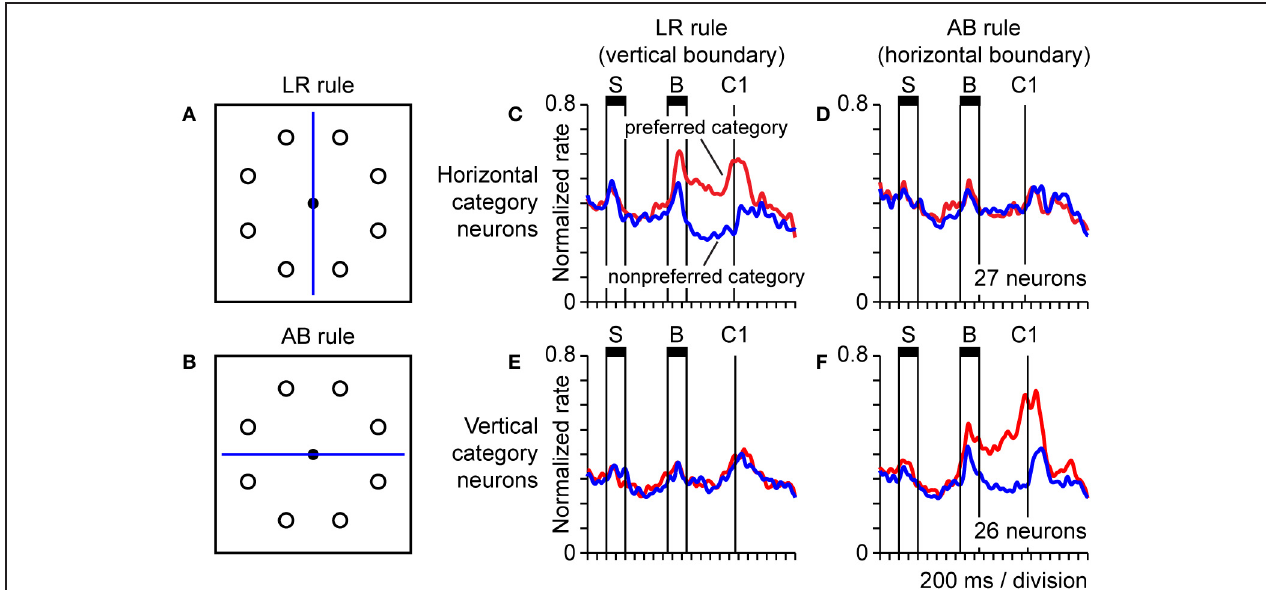
FIGURE 8 | Neural population activity encoding categorical spatial relationships in posterior parietal cortex area 7a. Monkeys performed a task in which they assigned a spot sample stimulus to one of two spatial categories on the basis of the spatial relationship between the sample and a line serving as a category boundary. We presented the sample and category boundary stimuli at different times in the trial, separated by an intervening delay. The durations of the sample and boundary cue are indicated by horizontal bars labeled “S” and “B,” respectively (C–F) . Monkeys reported their categorical judgment by pressing a response key when a subsequent choice stimulus appeared in the same spatial category as the sample (the time of onset of the first choice is labeled “C1”) (A,B) . Circular array of sample stimulus positions and category boundary shown bisecting the array